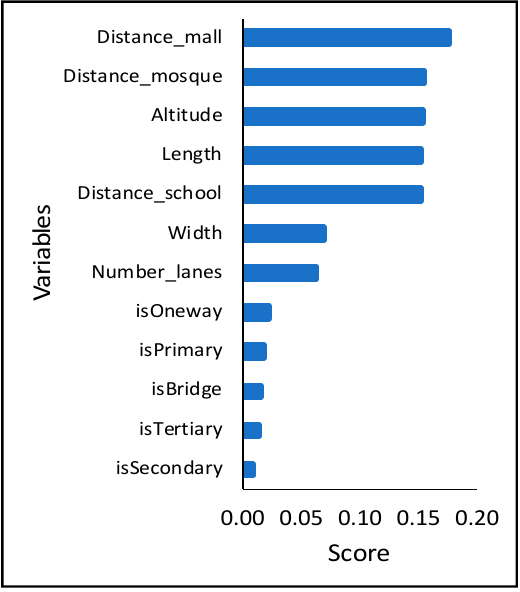
Figure 9. The characteristics of WSR.